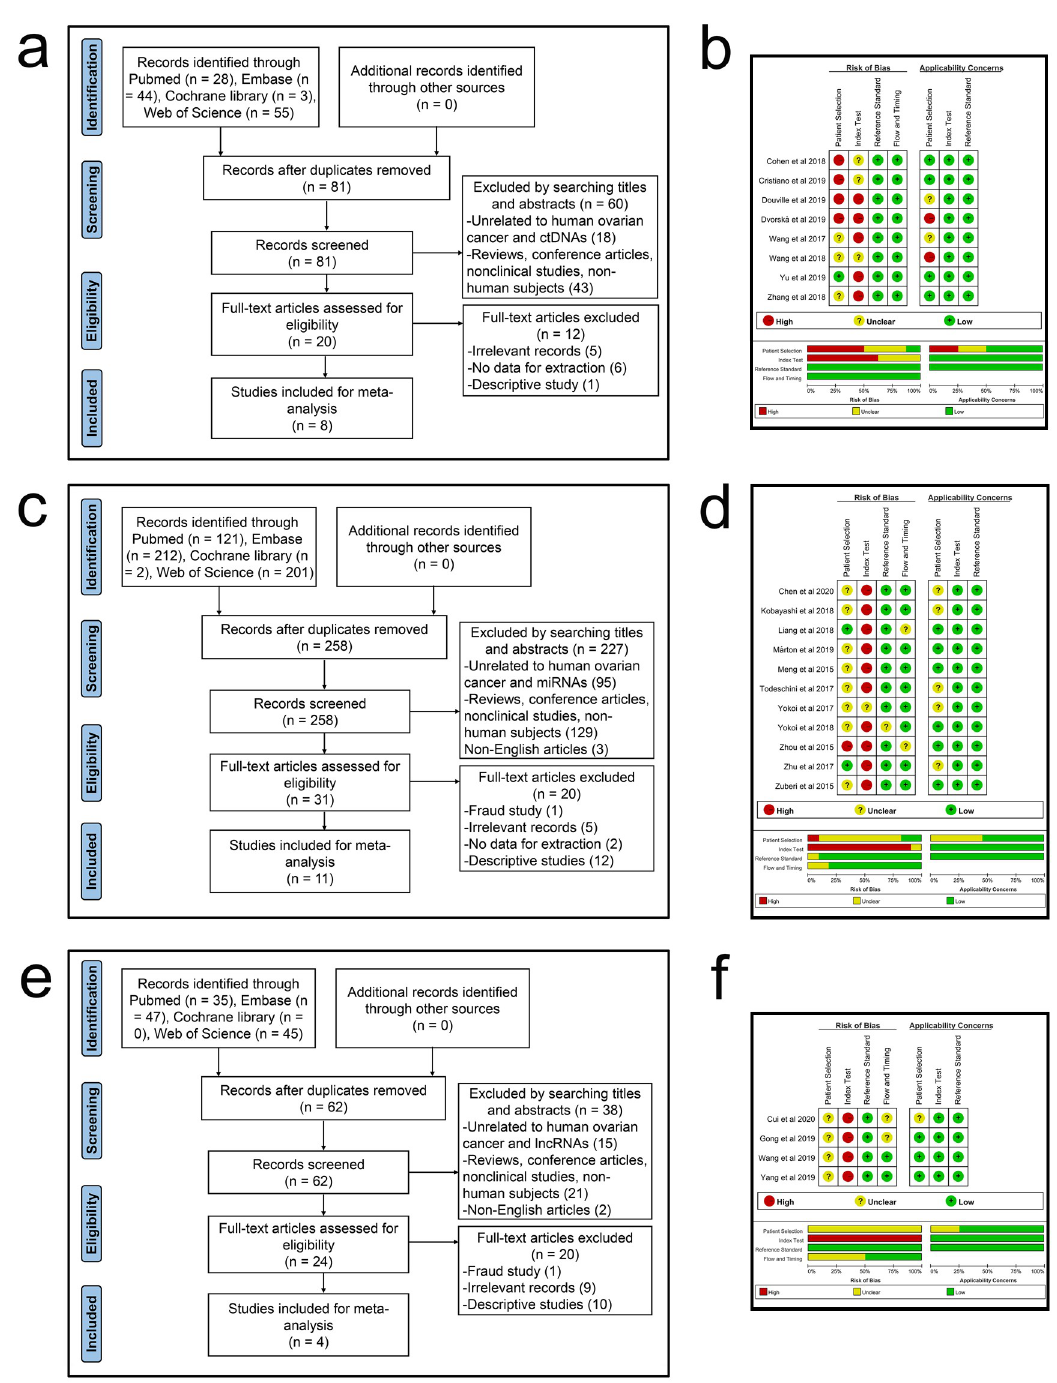
Fig 1. Flowcharts of literature search and identification and graphs of risk of bias and applicability concerns. (a) A flowchart of ctDNA. (b) A graph of bias risk and applicability concerns of ctDNA. (c) A flowchart of miRNAs. (d) A graph of bias risk and applicability concerns of miRNAs. (e) A flowchart of lncRNAs. (f) A graph of bias risk and applicability concerns of lncRNAs.